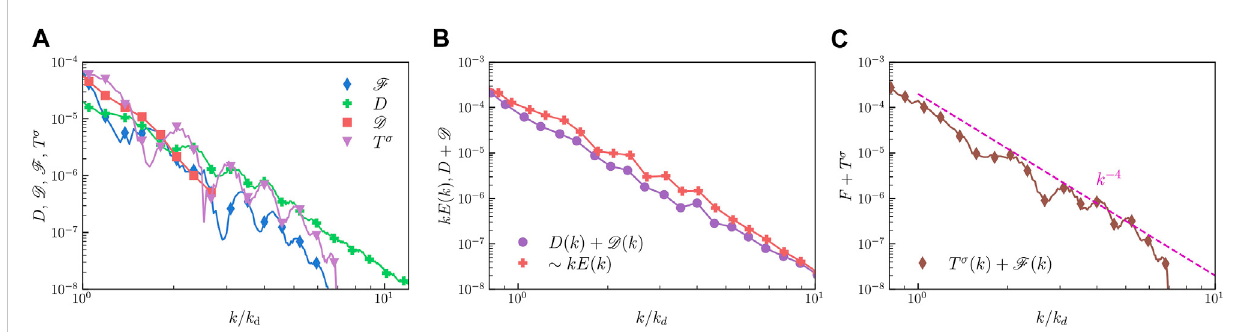
FIGURE 6 (A) Zoomed in plot showing contributions to the spectral energy budget for k > k d . (B) Log-log plot showing comparison of the scaled dissipation spectrum~ kE (K) andthenetdissipation D ( k ) + D ( k ) for k > k d . (C) Log-logplotshowingdifferentscalingregimesinthenetenergyinjection F ( k ) + T σ ( k ) for k > k d